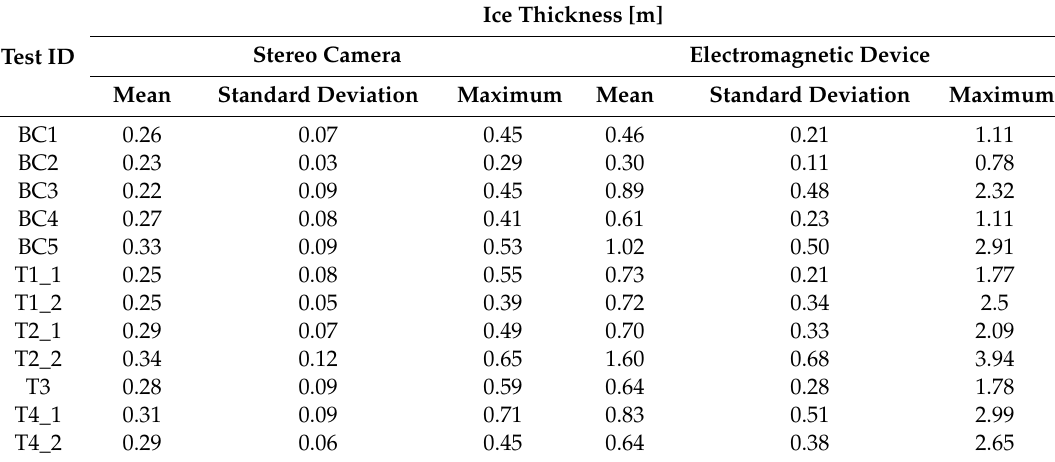
Table 6. Measured ice conditions during the maneuver tests.